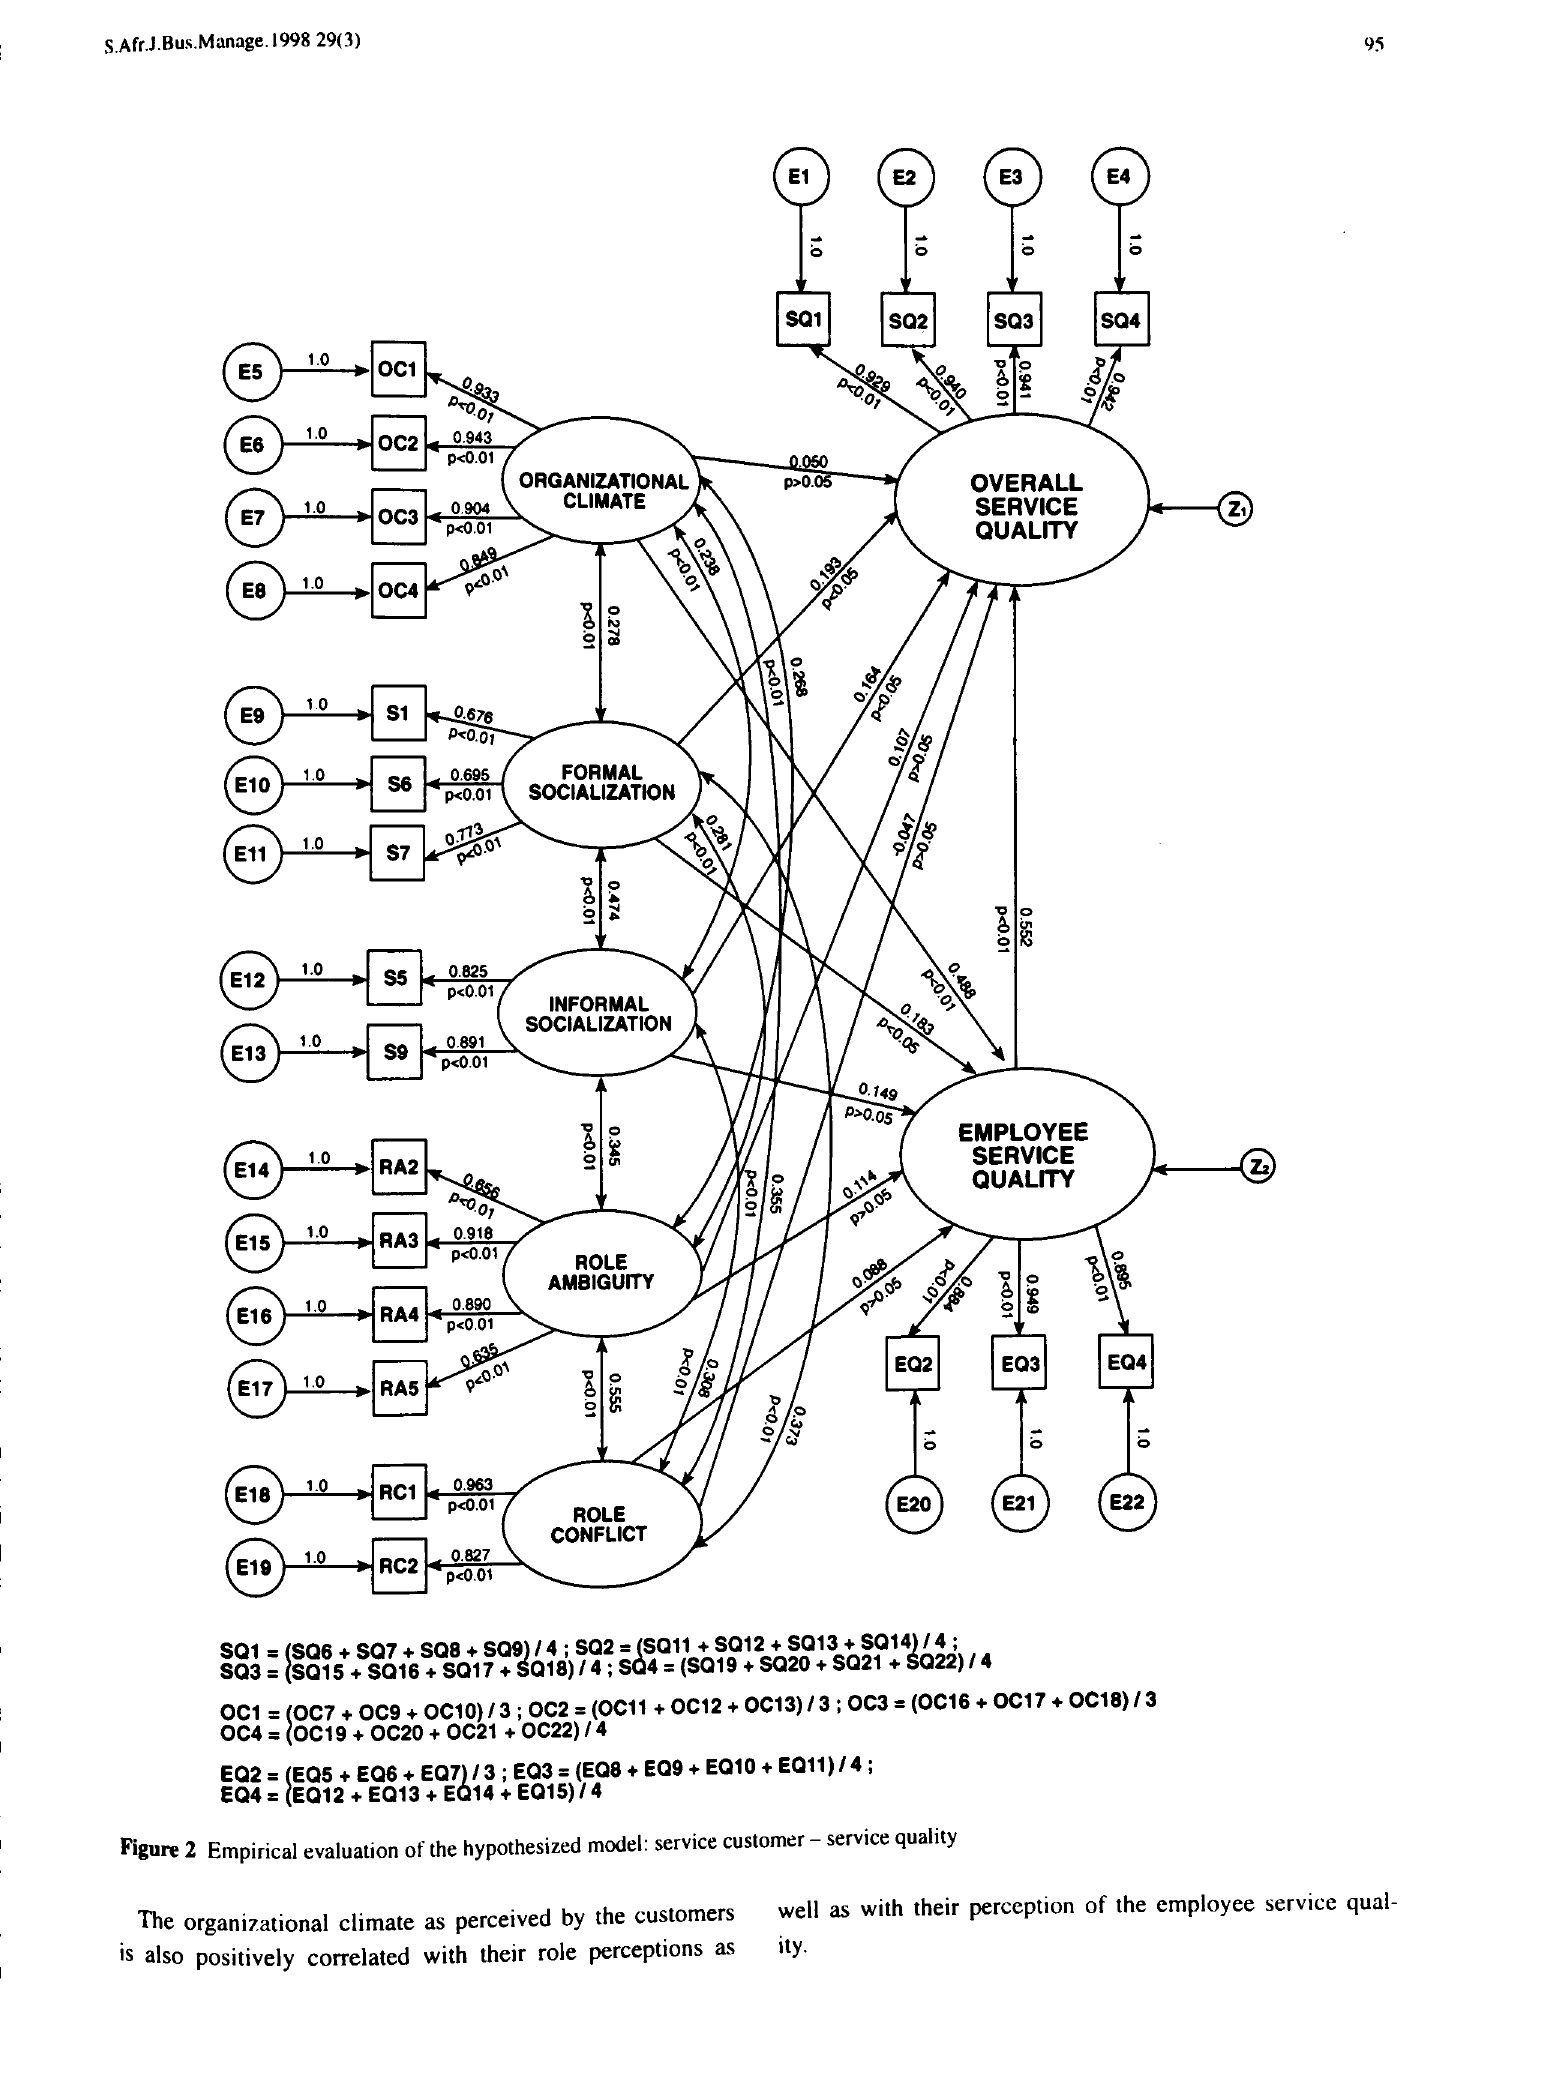
well as with their perception of the employee service qual